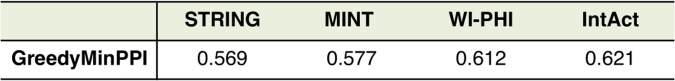
AUC scores on GreedyMinPPI with the four databases.